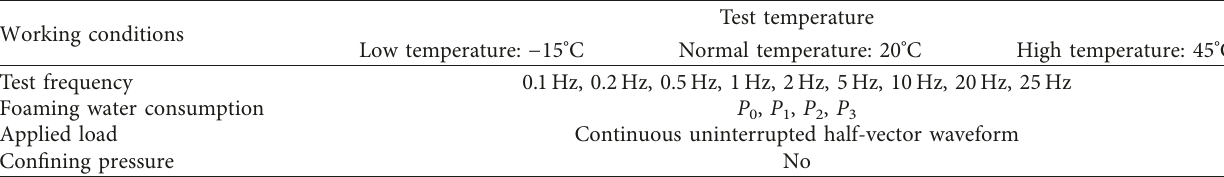
Table 4: Research and design scheme of dynamic characteristics of warm mix foamed asphalt mixture.